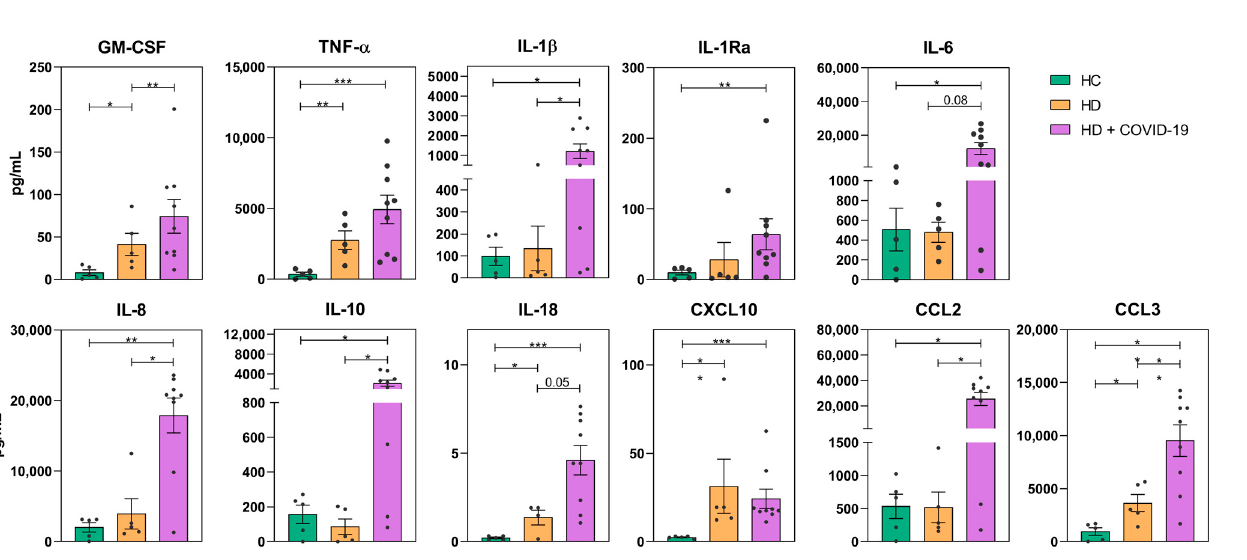
Figure 3. Analysis of monocyte function in HC, HD and HD + COVID-19 patients. Monocyte pro- duction of 11 cytokines measured in supernatant of monocyte in vitro culture upon LPS stimulation, *, p < 0.05; **, p < 0.01; ***, p <